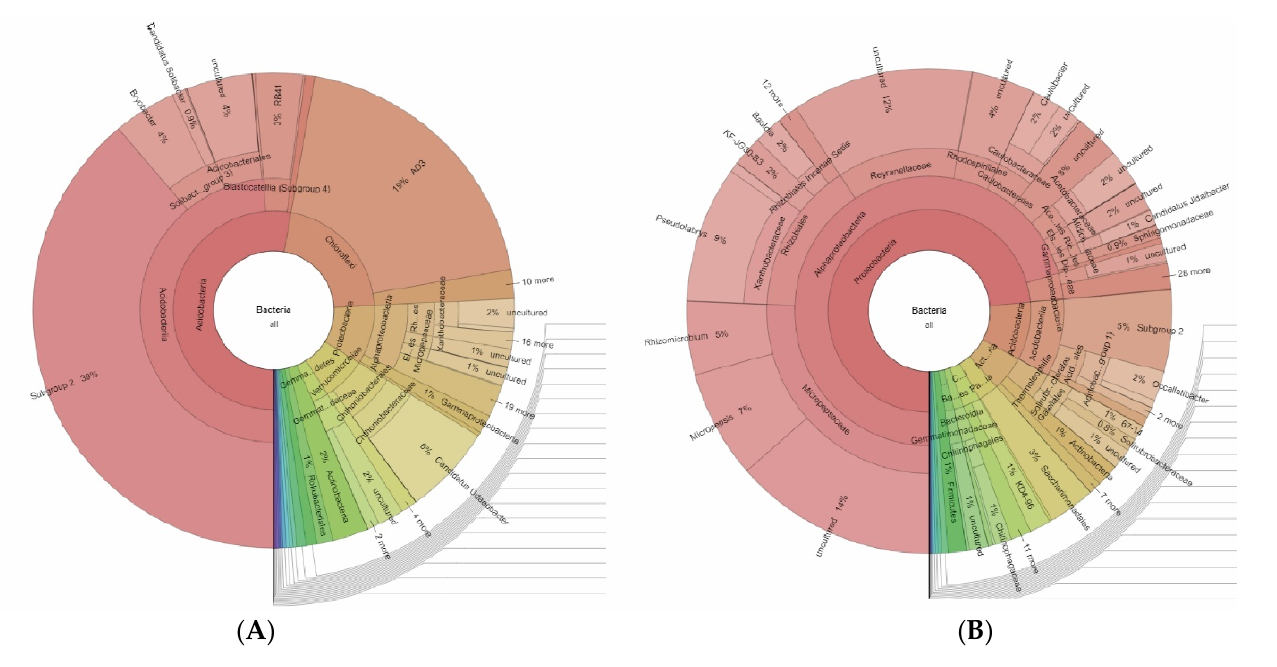
Figure 6. Phylogenetic map of the structure of the bacterial component (%) of the buried ( A ) and modern ( B ) horizons of volcanic stratified ochre soil.